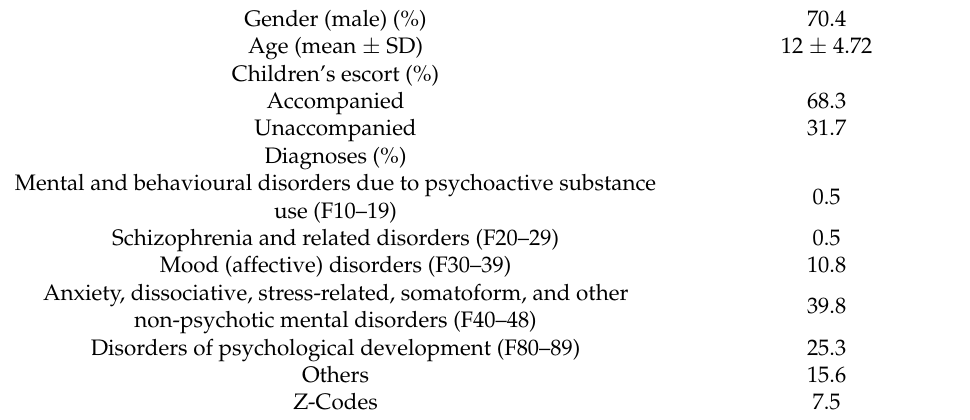
Table 2. Children Patients’ Characteristics and diagnoses ( n =